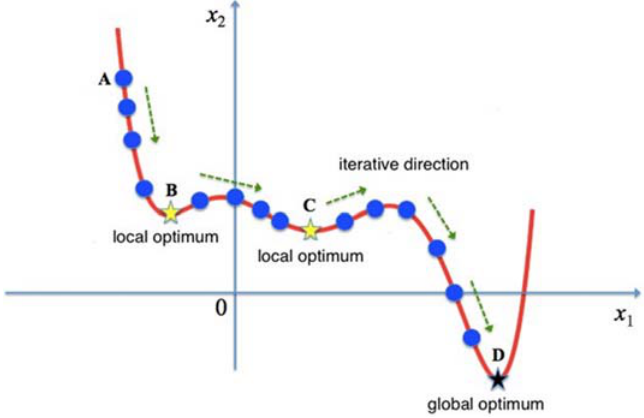
Figure 7. Representation of the SA algorithm.